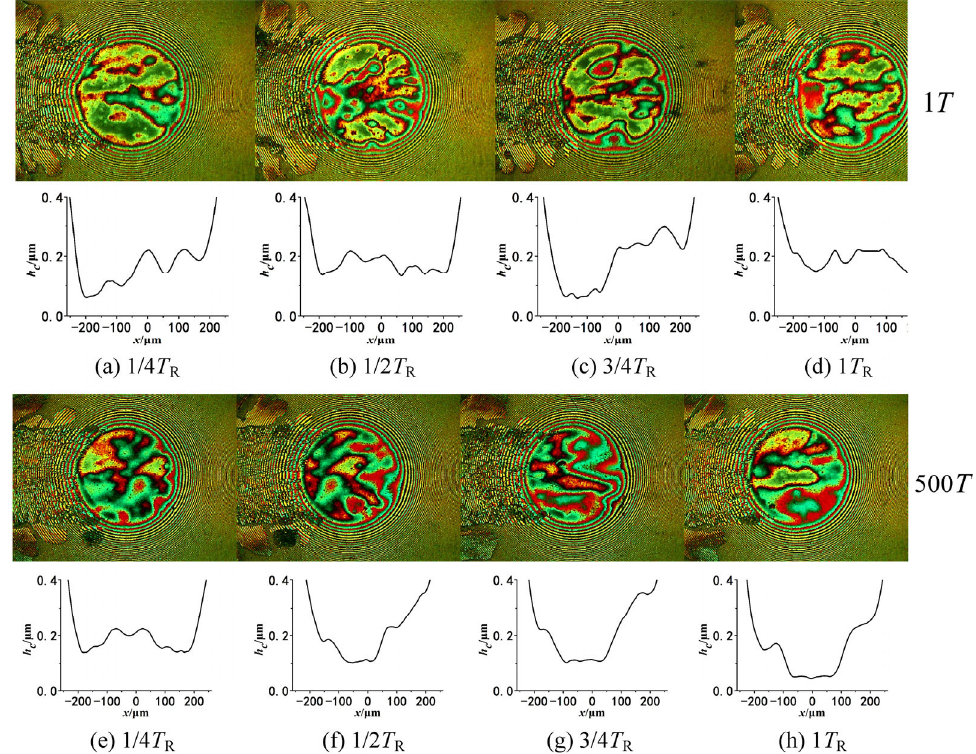
Fig. 4 Interferograms and midsection film thickness during 1st and 500th cycle under pure rolling steady-state motion ( v e = 0.01 m/s, w = 50